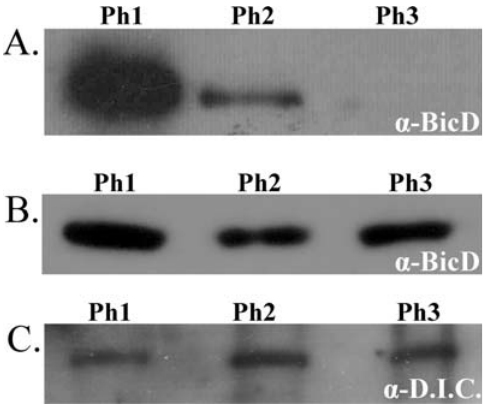
Figure 4. Levels of BicD on the lipid droplets decrease sharply with time. A: Lipids purified from staged one hour collections were probed for BicD and showed a large decrease in the amount of BicD on the droplet from phase I to III. Each lane was loaded with an equivalent amount of purified protein. B: During this same time, embryonic BicD levels are approximately constant. Each lane was loaded with an equivalent amount of total protein. C: Phase specific lipid purifications suggest that dynein levels on the droplets are approximately constant throughout phase I–III. Equivalent amounts of protein were loaded per